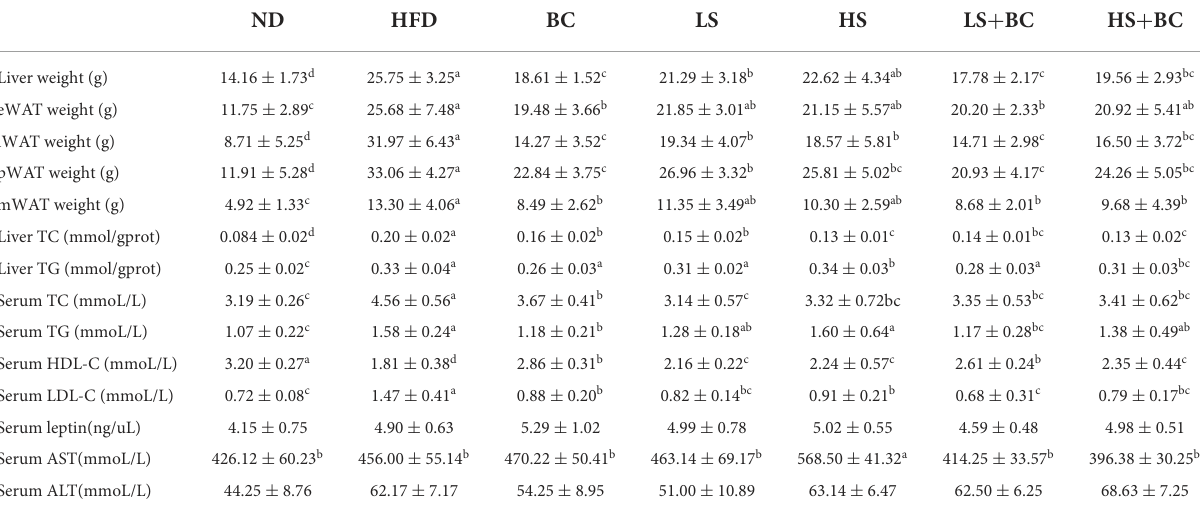
TABLE 1 The liver weight, adipose tissues weight, liver and serum biochemical concentrations of TC, TG, HDL-C, LDL-C, leptin, AST and ALT in